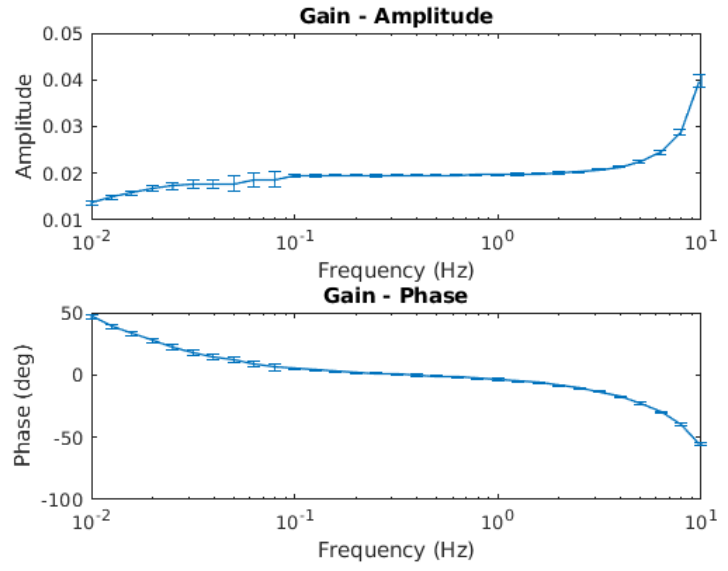
Figure 8. Calibrated gain of an 18 m WNRS + MB3. Top panel is the amplitude of the gain, and the bottom panel is the phase of the gain in degrees. For each frequency, the mean and standard deviations (vertical interval) are